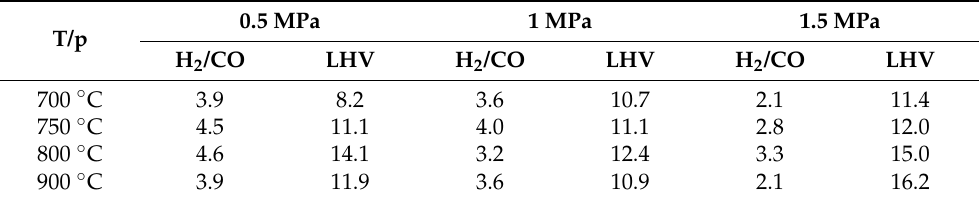
Table 3. The H 2 /CO ratio and LHV of gas from steam gasification of